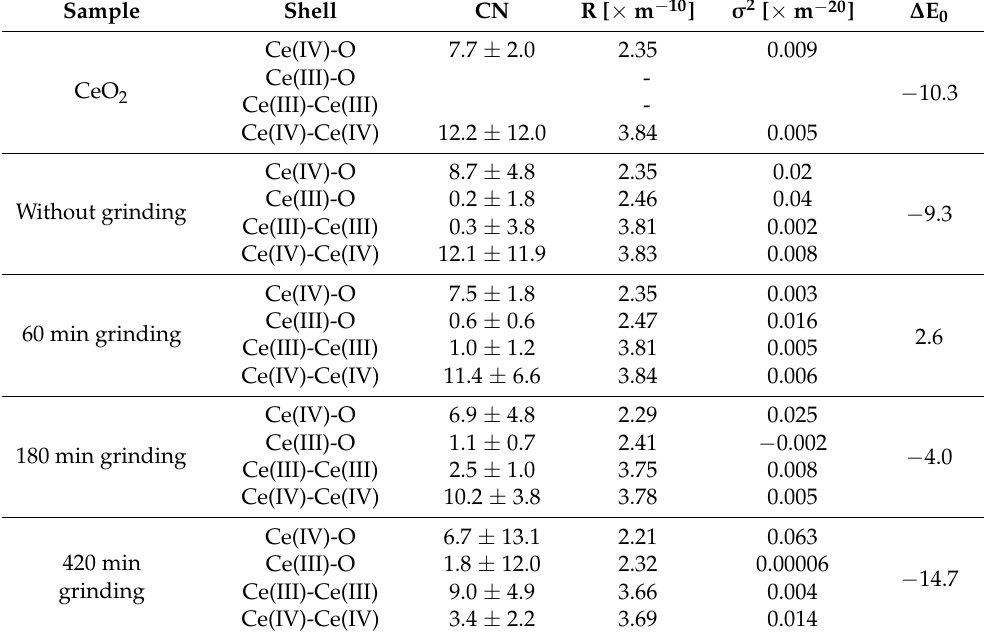
Table 7. Cerium fitting results assuming four kinds of cerium shell for tetravalent cerium oxide, samples by grinding with microwave irradiation in the radial distribution